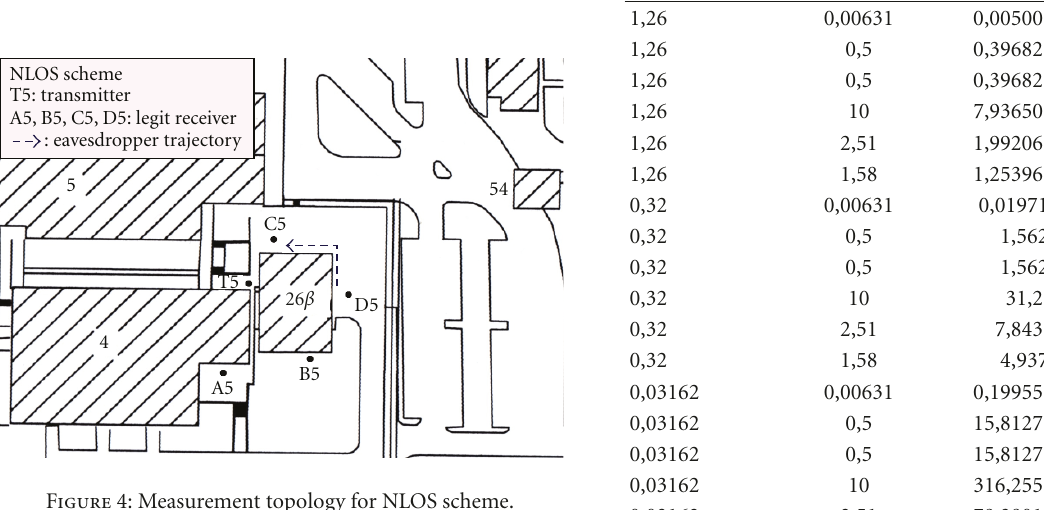
Table 2: P ( C s > 0) for OLOS-1 (T3) scheme. Pr legit.